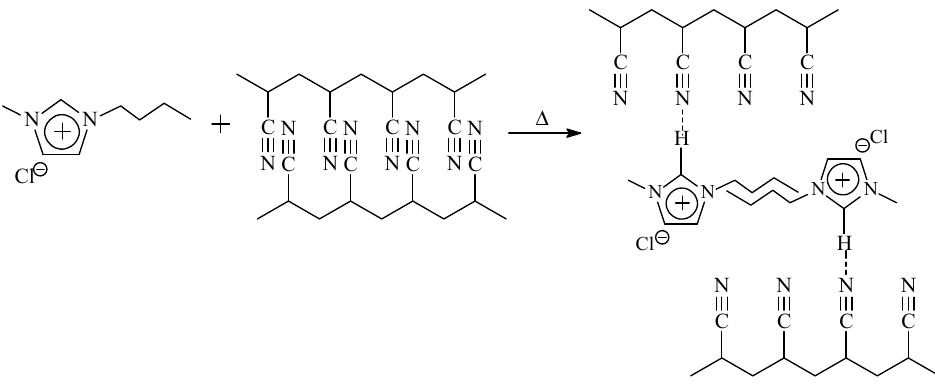
Scheme 2. Schematic presentation of H-bonding between imidazolium salt and nitrile groups.